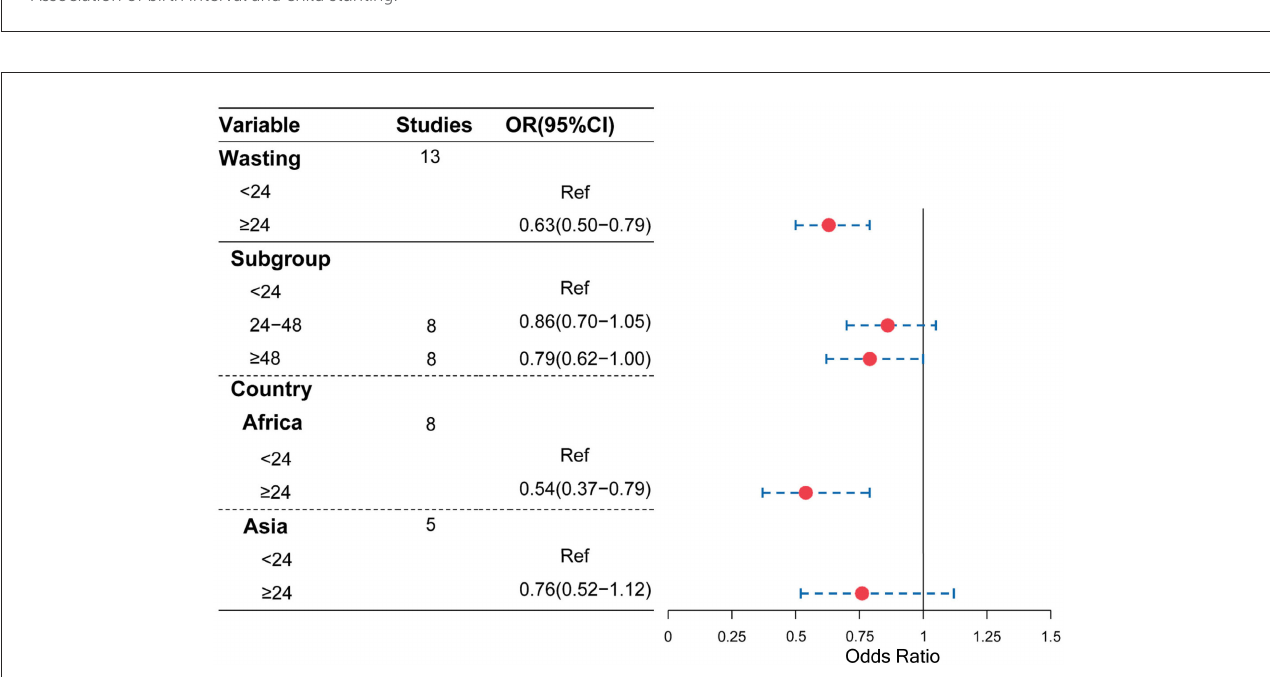
mothers with poor nutritional status, those with social-economic problems, and those with limited access to quality healthcare